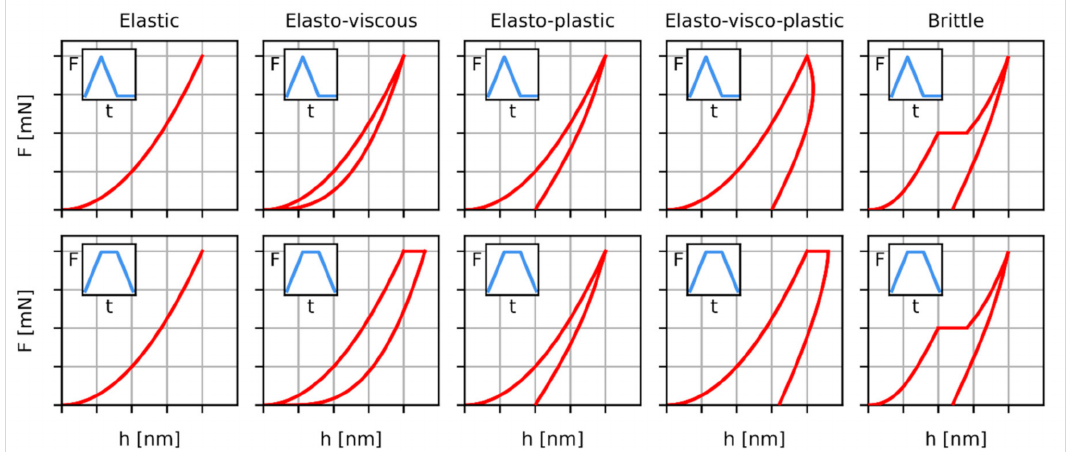
Figure 1. Schematic shapes of load–displacement curves ( F - h curves) for five groups of materials according to their dominant mode of deformation during indentation experiments. The upper and lower rows show the F - h curves during triangular and trapezoidal loading, respectively. For the sake of clarity, the F - t curves that represent the loading are shown in small inset of each